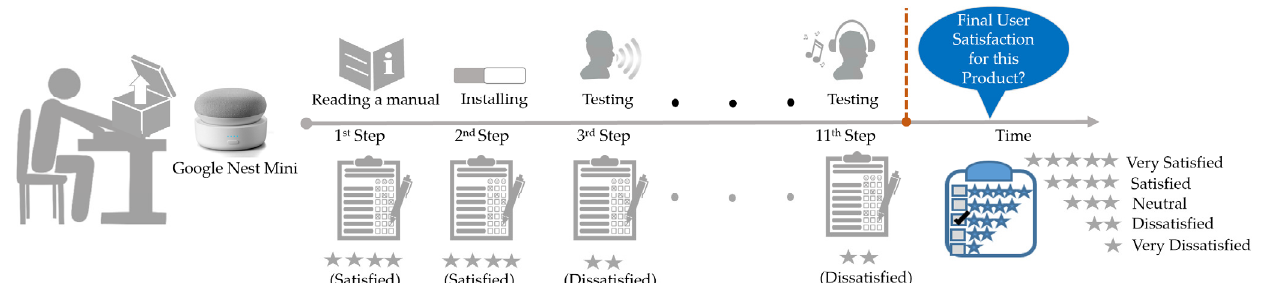
Figure 9. Evaluating user satisfaction while users set up the Google Nest Mini. Table 2. Performance of prediction models of final user satisfaction for the Google Nest Mini smart